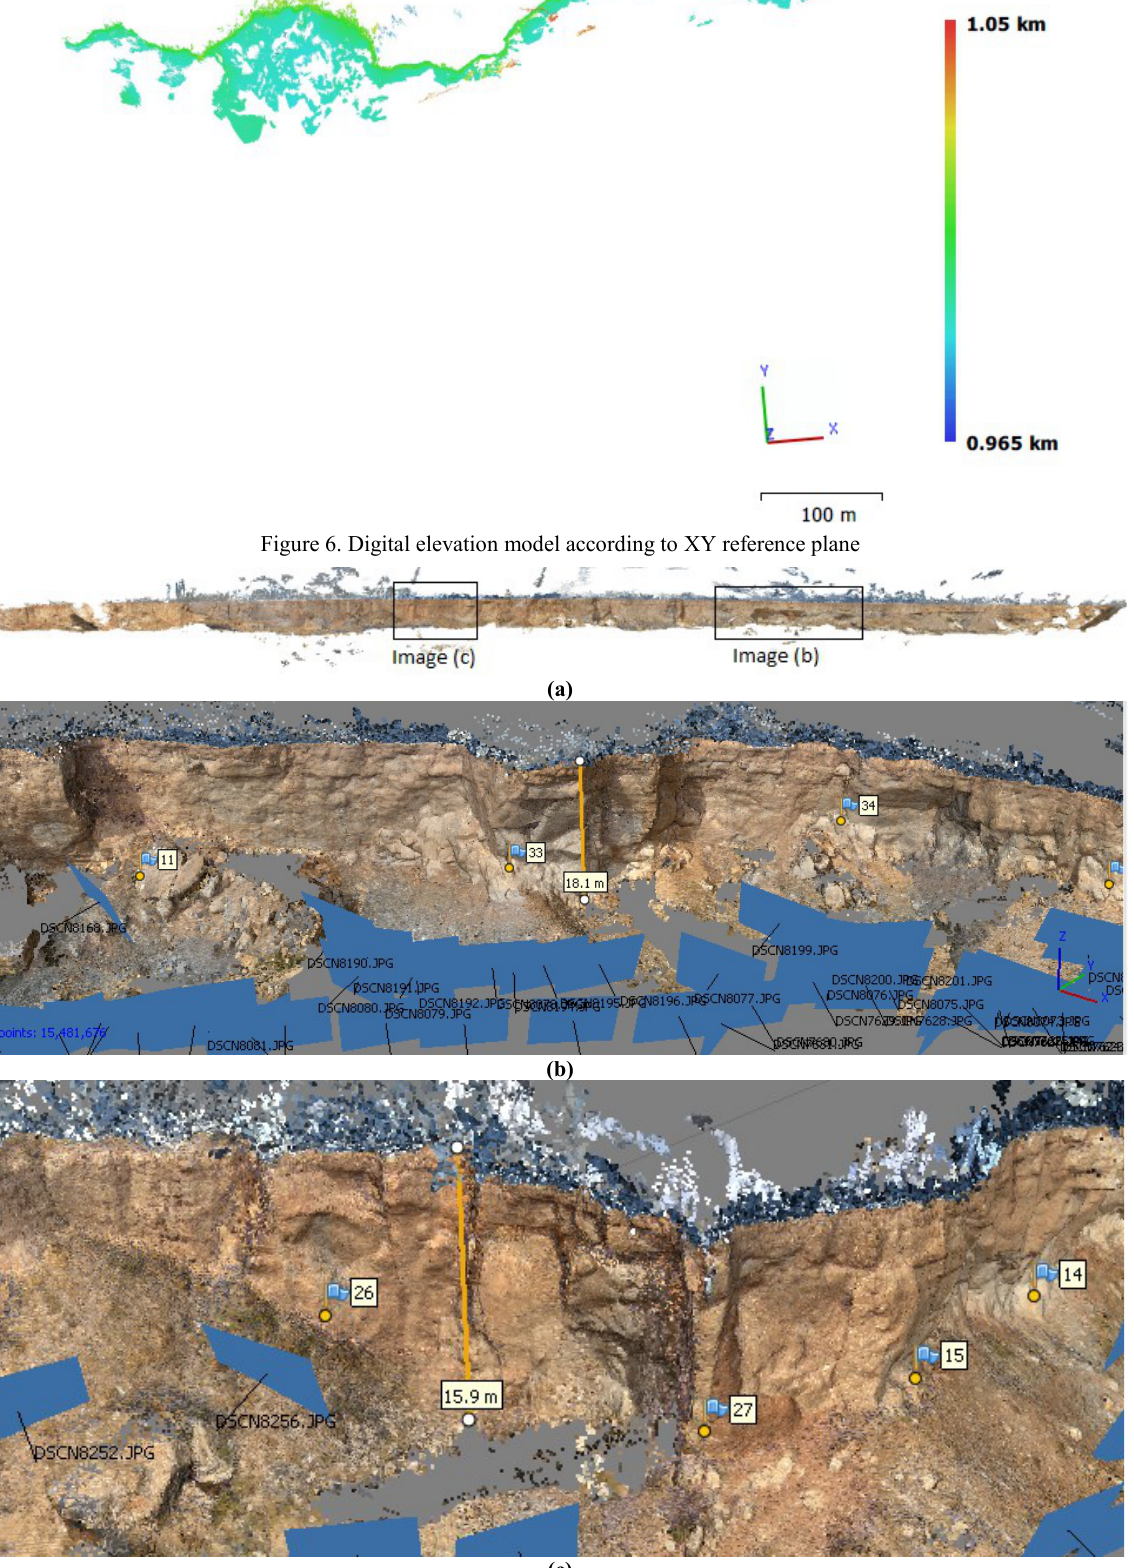
Figure 7. a) Orthomosaic image, b) and c) height measurement on the